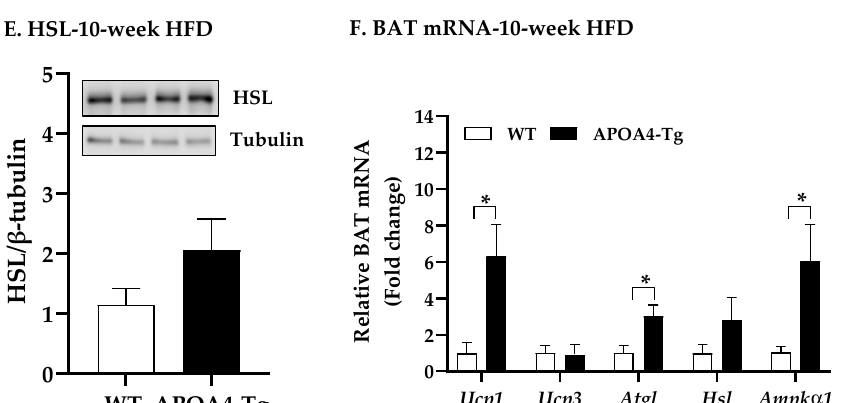
Figure 4. Levels of plasma apolipoproteins ( A ), thermogenic protein ( B ), tyrosine hydroxylase (TH)